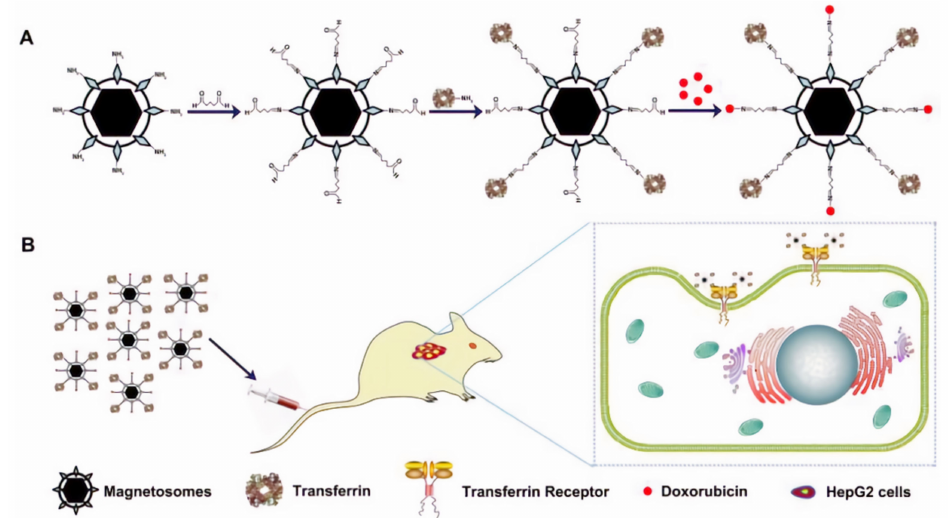
Figure 23. Schematic depiction of formulation of Tf-BMs-DOX ( A ). The antitumor of Tf-BMs-DOX in vivo ( B ). Reprinted from [245], license CC BY 4.0.